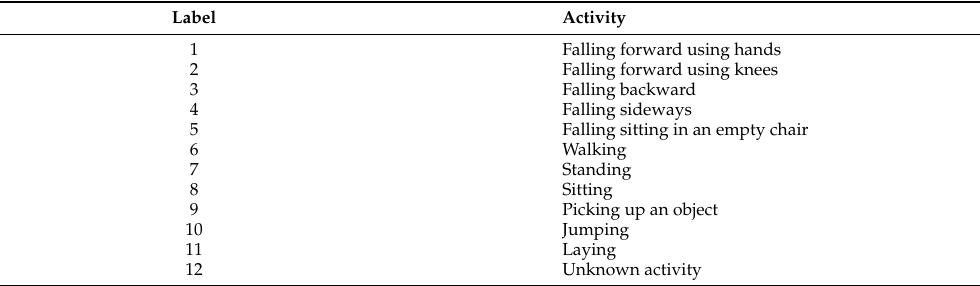
Table 1. UP-FALL